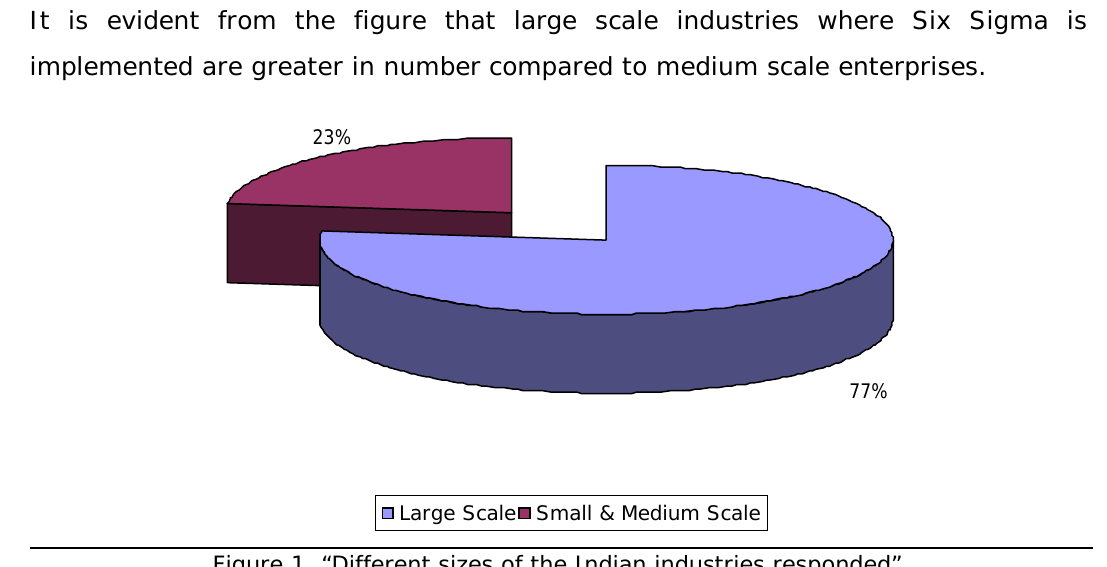
Figure 1. “Different sizes of the Indian industries responded”.